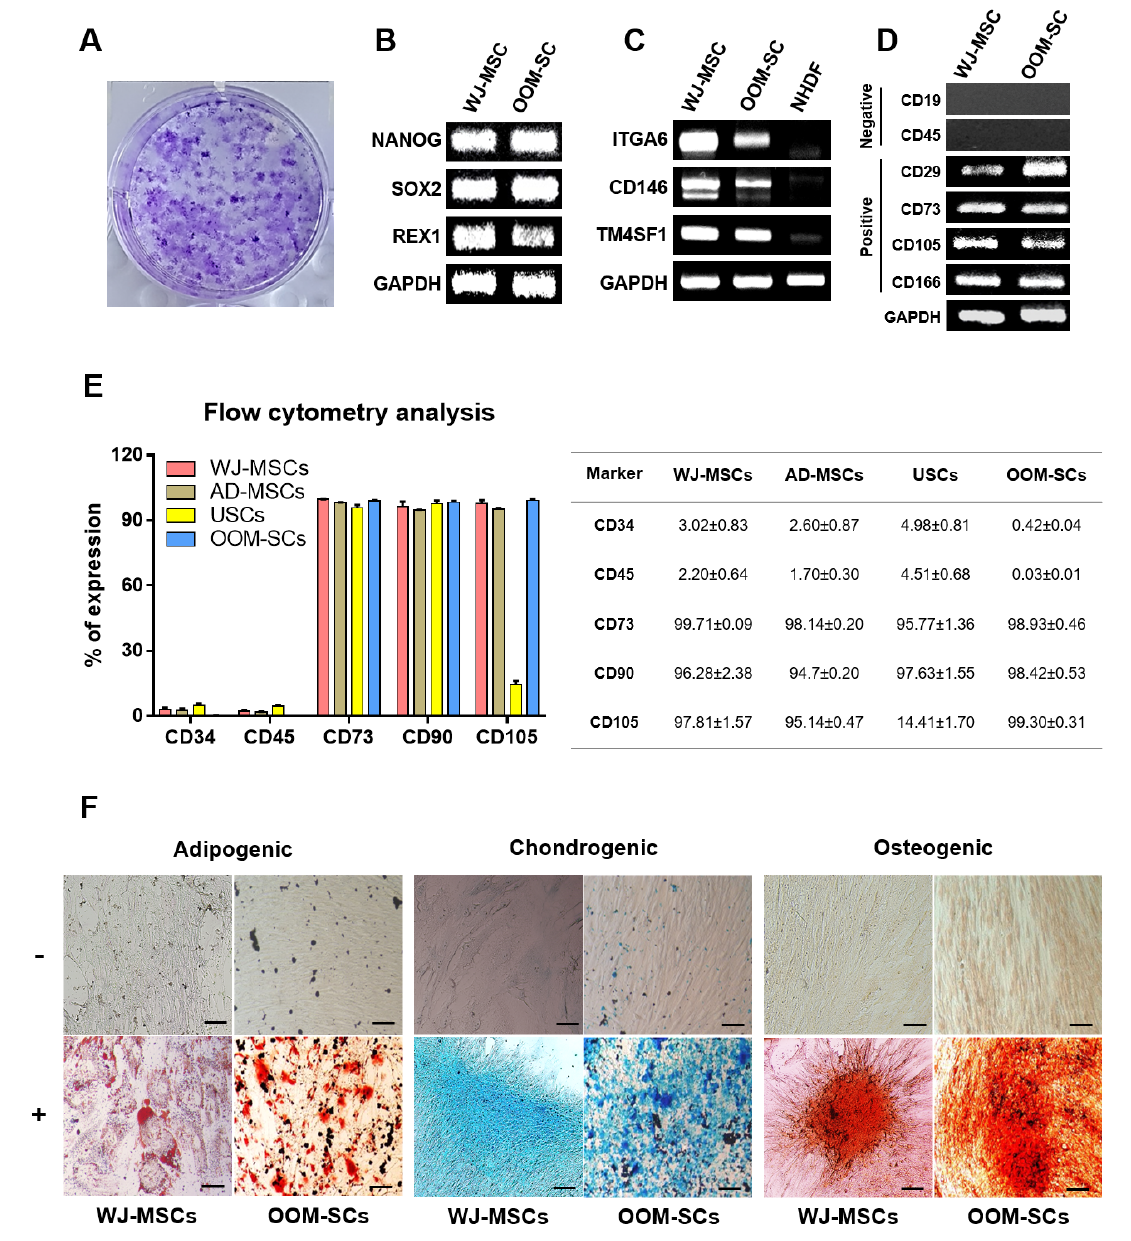
Figure 2. Verification of OOM-SCs Characteristics. ( A ) Microscopic images depict the CFU of OOM-SCs that were visualized with 0.15% crystal violet solution after two weeks of culture. Images of the stained colonies were captured using phase-contrast microscopy. ( B ) RT-PCR results of the expression of the stemness markers Nanog, Sox2, and Rex1 in comparison with those of WJ-MSCs. GAPDH was used as a housekeeping gene. ( C ) RT-PCR results of specific markers, including ITGA6, CD146, and TM4SF1, distinguish between multipotent MSCs and NHDFs. These genes are only expressed in multipotent MSCs. ( D ) RT-PCR data for the expression levels of the surface markers of the isolated OOM-SCs compared with those of WJ-MSCs. These markers included the negatively (CD19 and CD45) and positively (CD73, CD105, and CD166) expressed markers. ( E ) FACS analysis for confirming the expression of the negative markers CD34 and CD45 and positive markers CD73, CD90, and CD105 for OOM-SCs, compared with those of WJ-MSCs. FACS results are summarized in the table (right panel), and all results are presented in percentages. ( F ) Microscopic images of adipogenic, chondrogenic, and osteogenic differentiation were evaluated by Oil Red, Alcian Blue, and Alizarin Red S staining, respectively. The upper and lower panels represent undifferentiated and differentiated cells, respectively. Scale bar = 200 µ